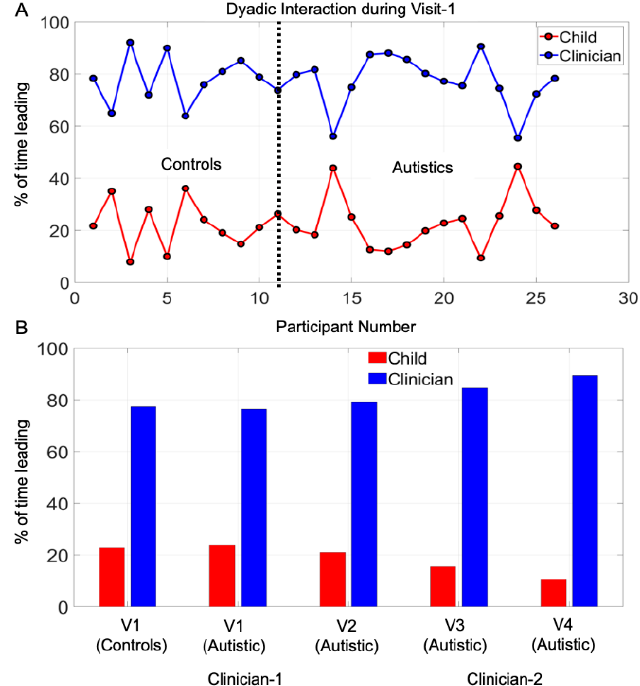
Figure 5. Monologue style of ADOS test. Rater leads social interaction a large percentage of the time for each child. ( A ) For all 26 children divided into neurotypical controls and autistics on the x-axis and on the y-axis, the % of time (taken across all ADOS tasks) that the rater or the child leads the interaction. Clinician rater leads on average for each child, across all tasks. ( B ) Group data per visit showing the summary of the % time that the person leads the social interaction.